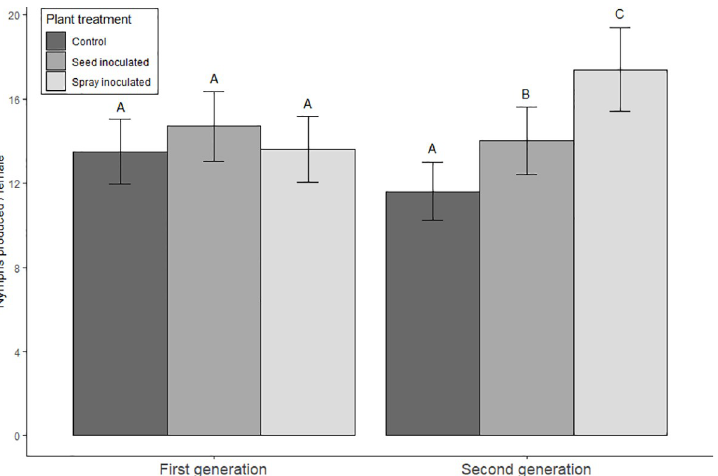
Fig 2. Mean number of nymphs produced by first- and second-generation apterous A . fabae when exposed to three treatments. The data presented are means from four pooled experimental runs. Error bars represent two times standard error. Different letters indicate statistically significant differences (p value < 0.05), where each generation is analyzed independently.